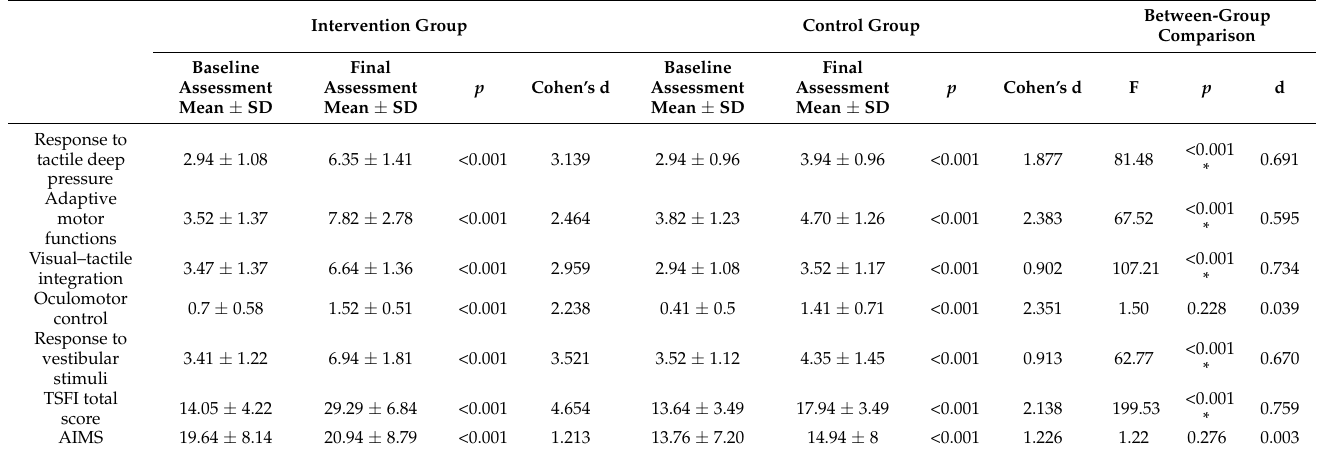
Table 3. Comparison of intra-group pre-treatment and post-treatment evaluations. Intervention Group Control Group